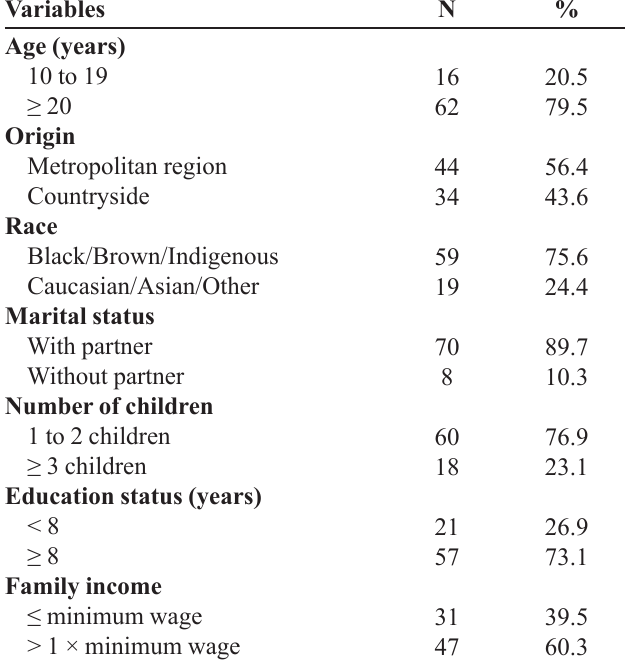
TABLE I – Distribution of the sociodemographic variables of puerperal women interned in HC/UFPE after